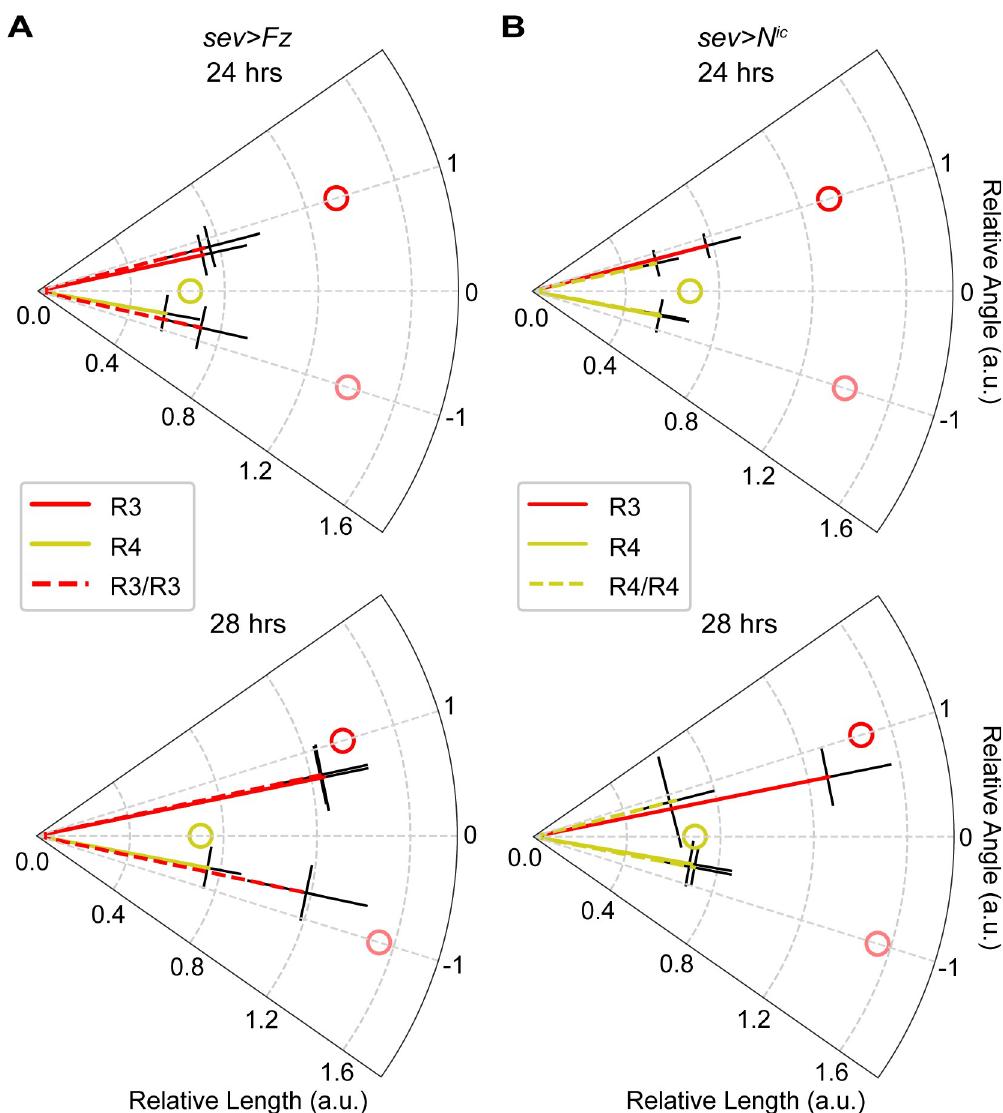
Fig 4. Extension speed is instrumental for asymmetrical targeting. Polar plots of relative lengths and angles for wild-type- like (R3/R4) and fate-transformed (R3/R3 or R4/R4) bundles under (A) sev > Fz and (B) sev > N ic conditions at 24 and 28 hrs APF. See S5 Fig for representative images of each condition. Radial coordinate: relative length; angular coordinate: relative angle; error bars: standard deviations for length or angle. Solid lines: control bundles; dashed lines: fate-transformed bundles. Open circles: mean of target centers. Sample numbers for growth cones at wild-type R3 position, wild-type R4 position, perturbed R3 position, and perturbed R4 position, respectively: sev > Fz at 24 hrs (n = 32, 47, 13, 13) or 28 hrs (n = 52, 143, 22, 22); sev > N ic at 24 hrs (n = 23, 46, 10, 10) or 28 hrs (n = 39, 113, 29, 29). n � 3 biological replicates for each genetics and time point. See S1 Table for p-values and S1 Data for data used to generate this